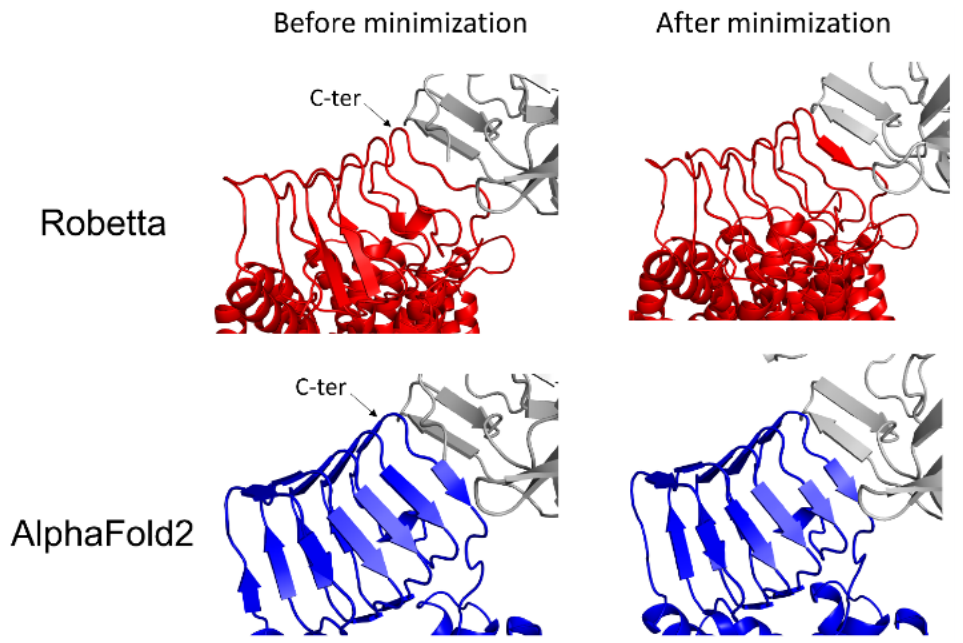
Figure 3. Structural conformational changes of BoNT/A1-h-SV2C complex involving the Robetta model (red) or the AlphaFold2 model (blue) after energy minimization.